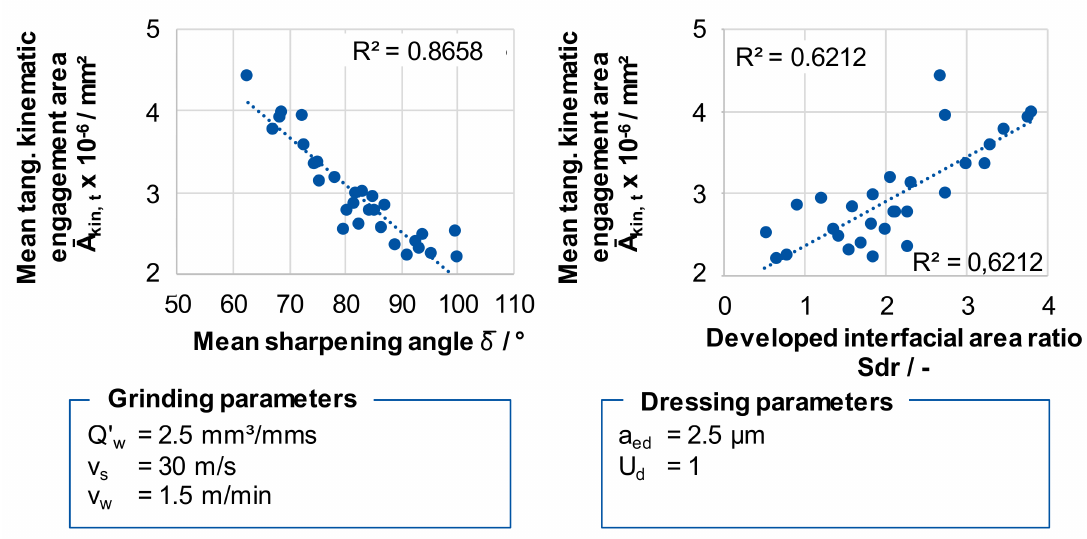
Figure 12. Correlation between the mean tangential kinematic engagement area, the mean sharpening angle and the developed interfacial area